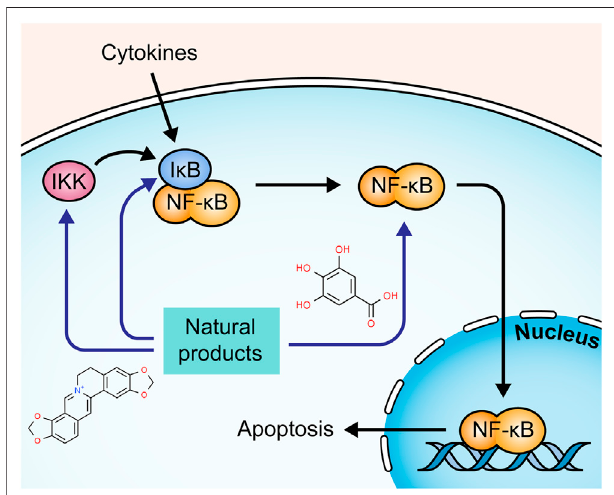
FIGURE5| Naturalproductsmodulate apoptosisofIECs throughNF κ B mediated pathway.